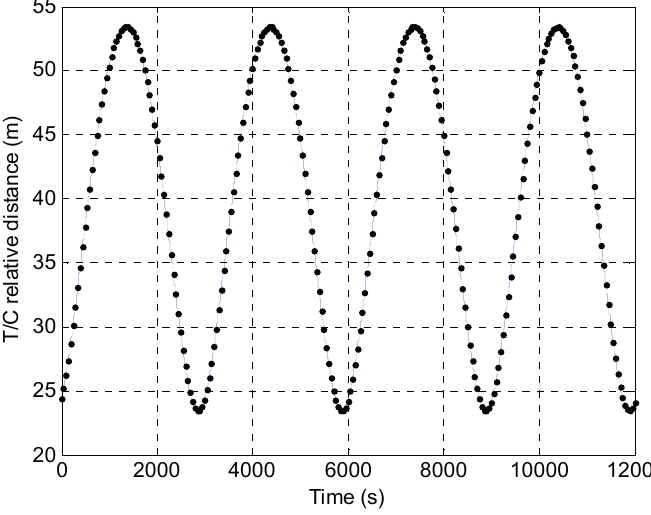
Figure 5. Time variation of the target-chaser relative distance along two consecutive orbits (in blue). The black dots indicate the time instants and the corresponding relative distances at which the TM algorithm is